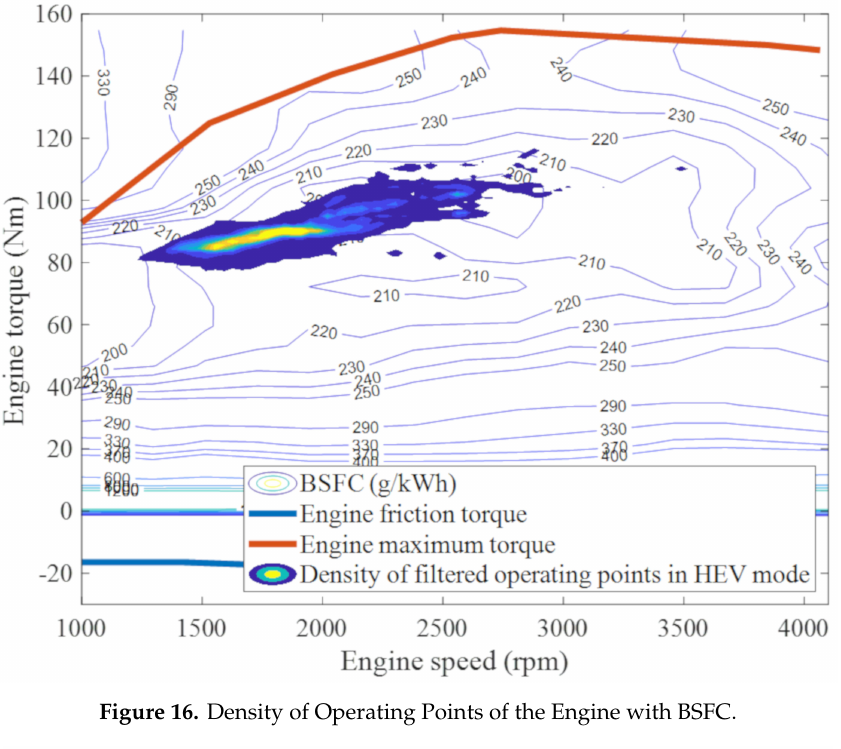
Figure 16. Density of Operating Points of the Engine with BSFC.